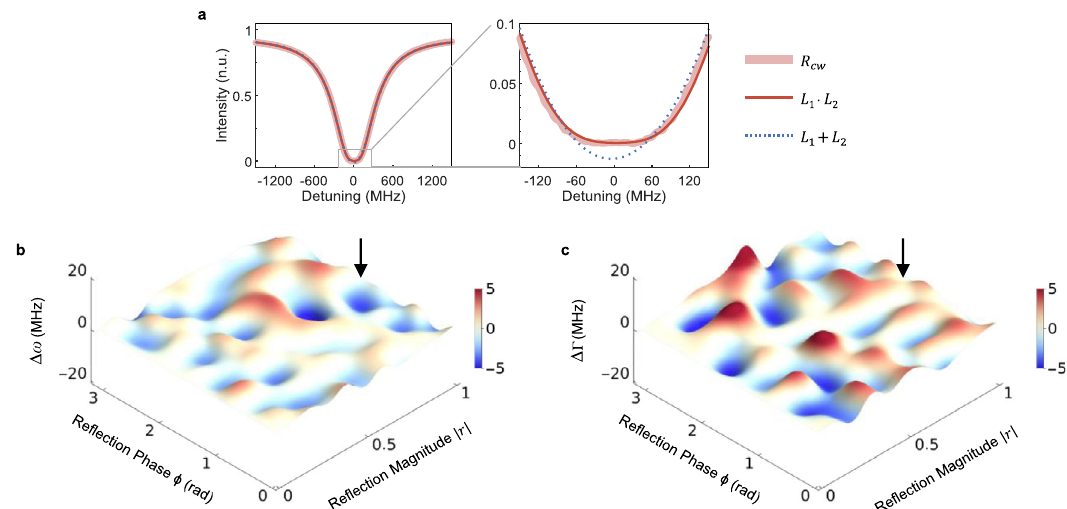
Fig. 2 Squared Lorentzian re fl ection spectra and reconstructed exceptional surface for CW input at critical coupling. a Re fl ection spectrum R cw obtained for fully re fl ective end-mirror, r j j ¼ 1, has quartic lineshape (left panel). A closer look into the resonance dip of R cw reveals the fl attening of the lineshape (cid:5) L þ L (product of two Lorentzians) rather than f ¼ L (sum of two Lorentzians). (right panel). Best curve fi t is obtained using the function f ¼ L (cid:8) (cid:9) 1 2 1 2 of the system when the system is operated at the critical coupling for a CW input. Curve fi tting to b , c Reconstructed ES in the 2D parameter space r j j ; ϕ the experimentally obtained R cw is used to estimate the real and imaginary parts of the complex eigenfrequency of the system at the EP where two eigenfrequencies coalesce. 4 ω in ( b ) and 4 Γ in ( c ) corresponds to the difference between the real and imaginary parts of two complex eigenfrequencies obtained from curve fi tting. Deviations from zero are attributed to curve fi tting noise. Arrows point to the locations of the spectrum on the